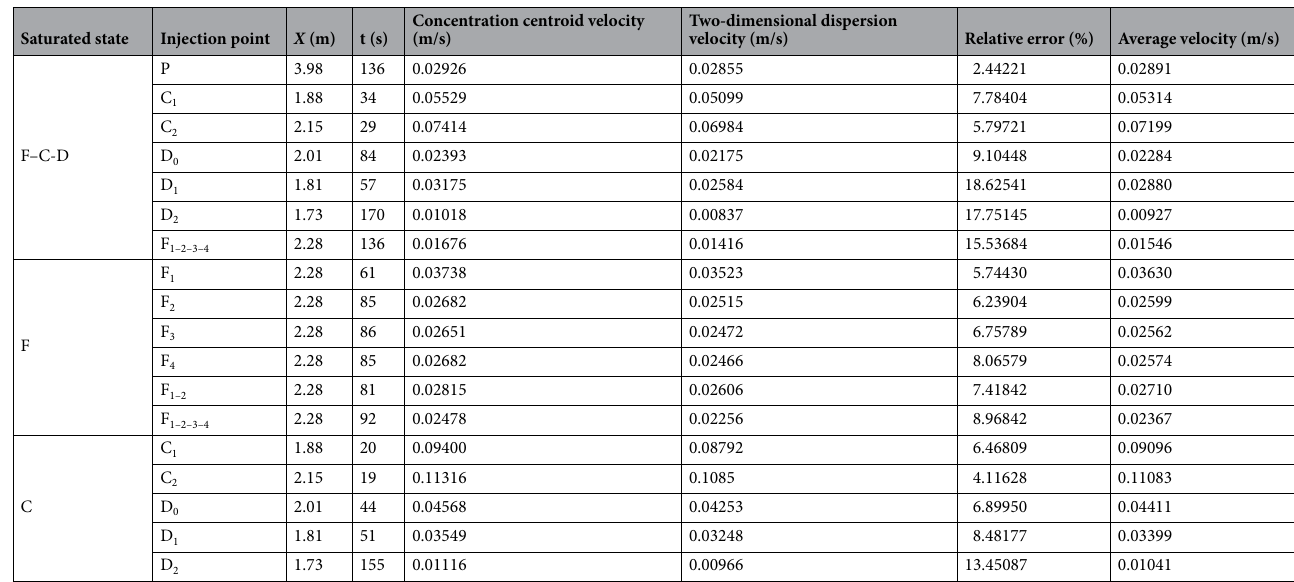
Table 2. The evaluation of mean velocity of tracer transport in fissure–conduit saturated